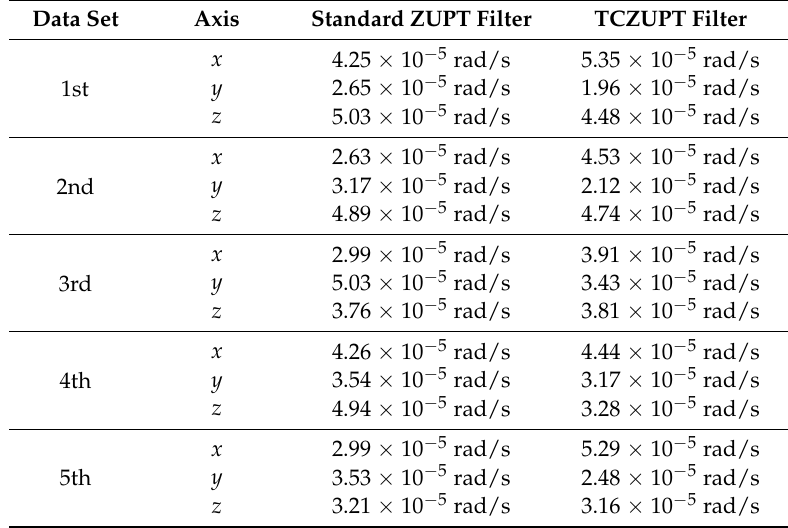
Table 8. Root Mean Squared Error (nominal conditions, 5 data sets).